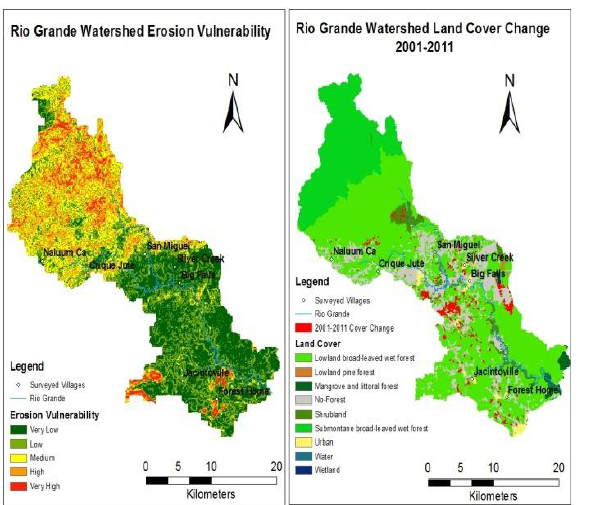
Figure 6. Rio Grande watershed erosion vulnerability and land cover change from 2001- 2011